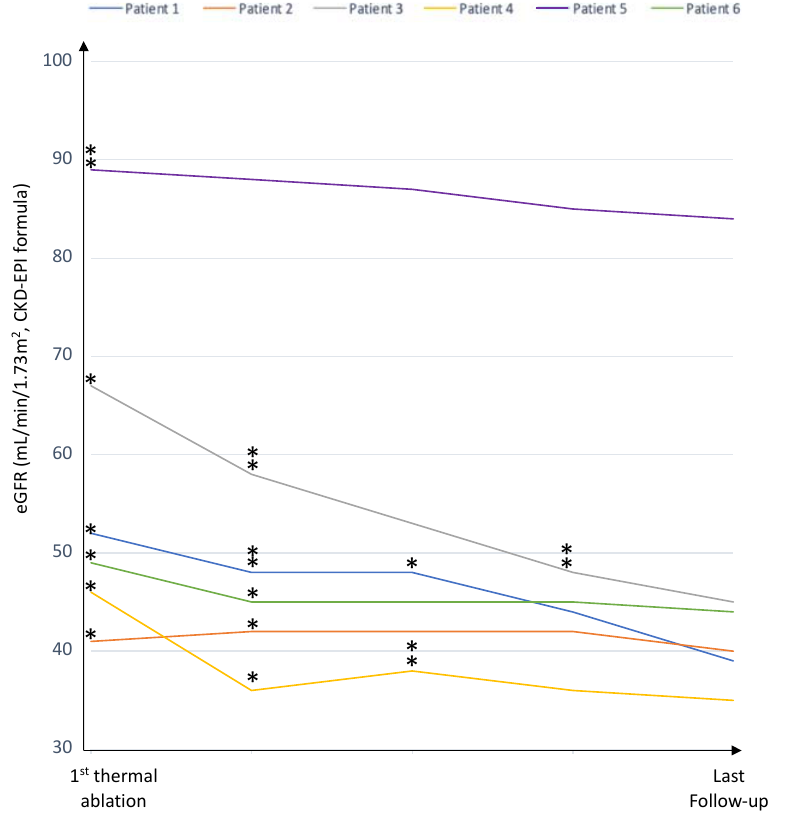
Figure 2. The renal function during the follow-up period for each of the six patients. *(one ablation) and **(two ablations): Se Creatinine level at the moment of TA for each ablation procedure .